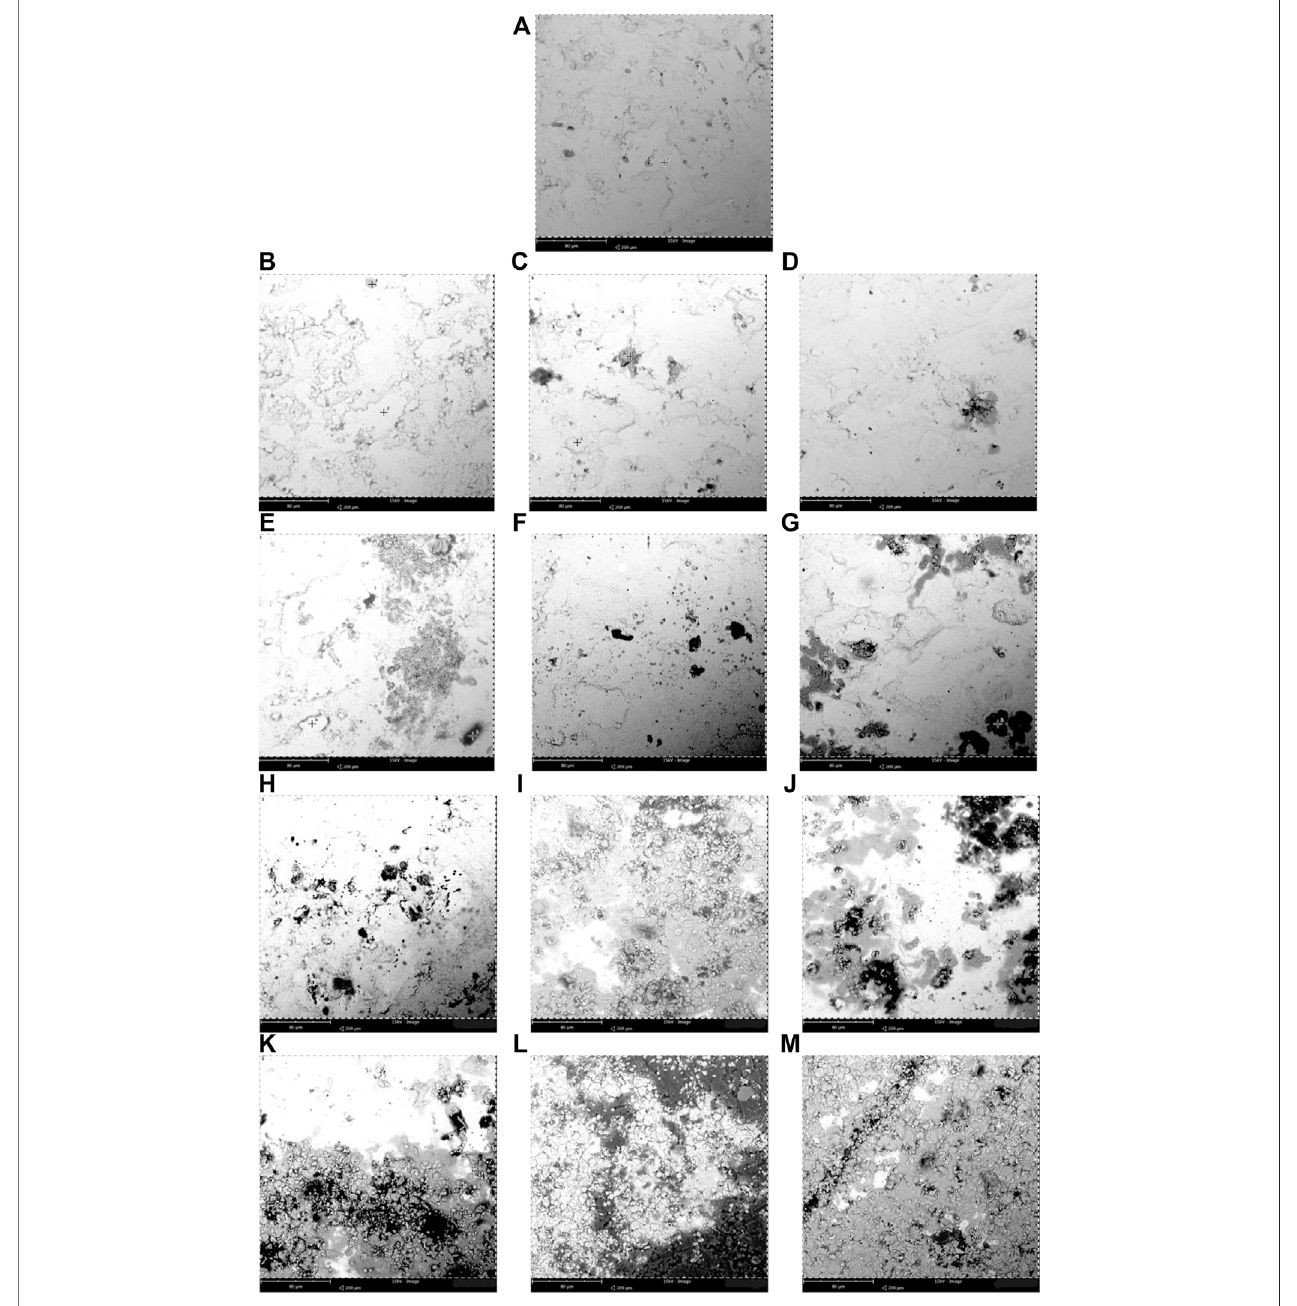
FIGURE 2 | Scanning electron microscopy (SEM) micrographs of corrosion observed at the immersed surface of the biodiesel-diesel blend mixtures with different immersion durations for mild steel (A) 0 day, (B – G) B5, B10, B15, B20, B25, and B30 at 150 days, (H – M) B5, B10, B15, B20, B25, and B30 at 300 days at room temperature (25 ° C – 30 °